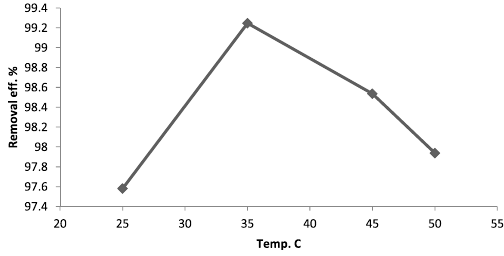
Fig. 4. Effect of temperatures on kerosene degradation from Klebsiella pneumonia sp.